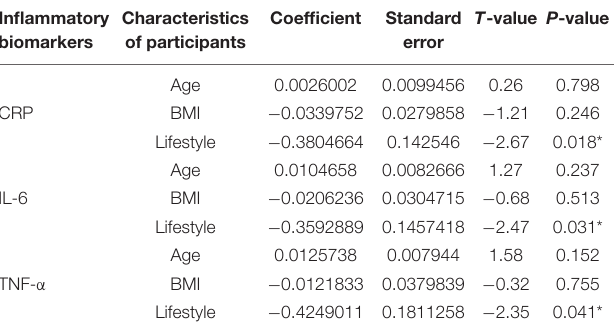
TABLE 2 | Meta-regression analysis for participants’ characteristics. Inflammatory